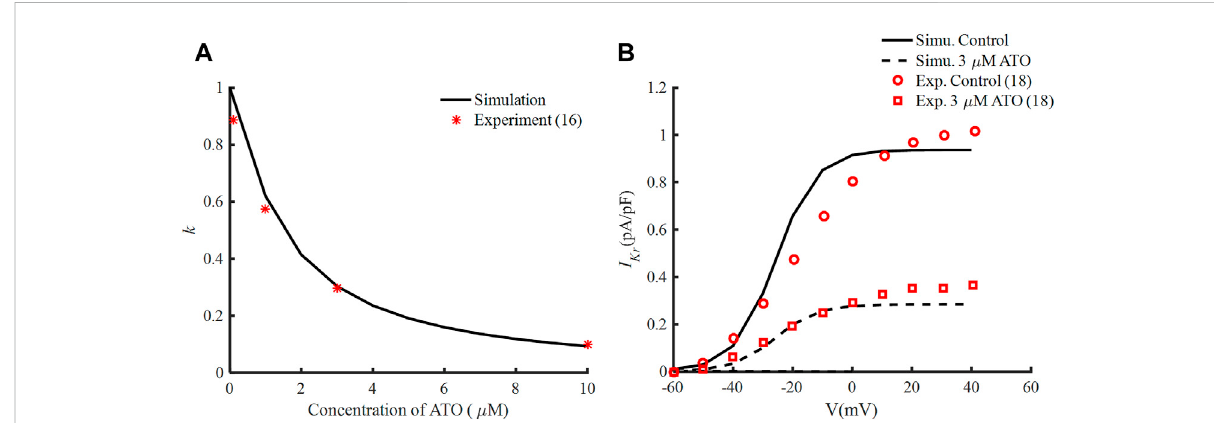
FIGURE 1 EffectsofATOandthehERGchannelcurrent. (A) Thenormalizedremainingmaximumconductanceof I Kr blockedbyATO. (B) Tailcurrentof I Kr under the conditions of control and 3 μ M ATO in the simulation model (black lines) and an experiment (red circle and square), respectively.